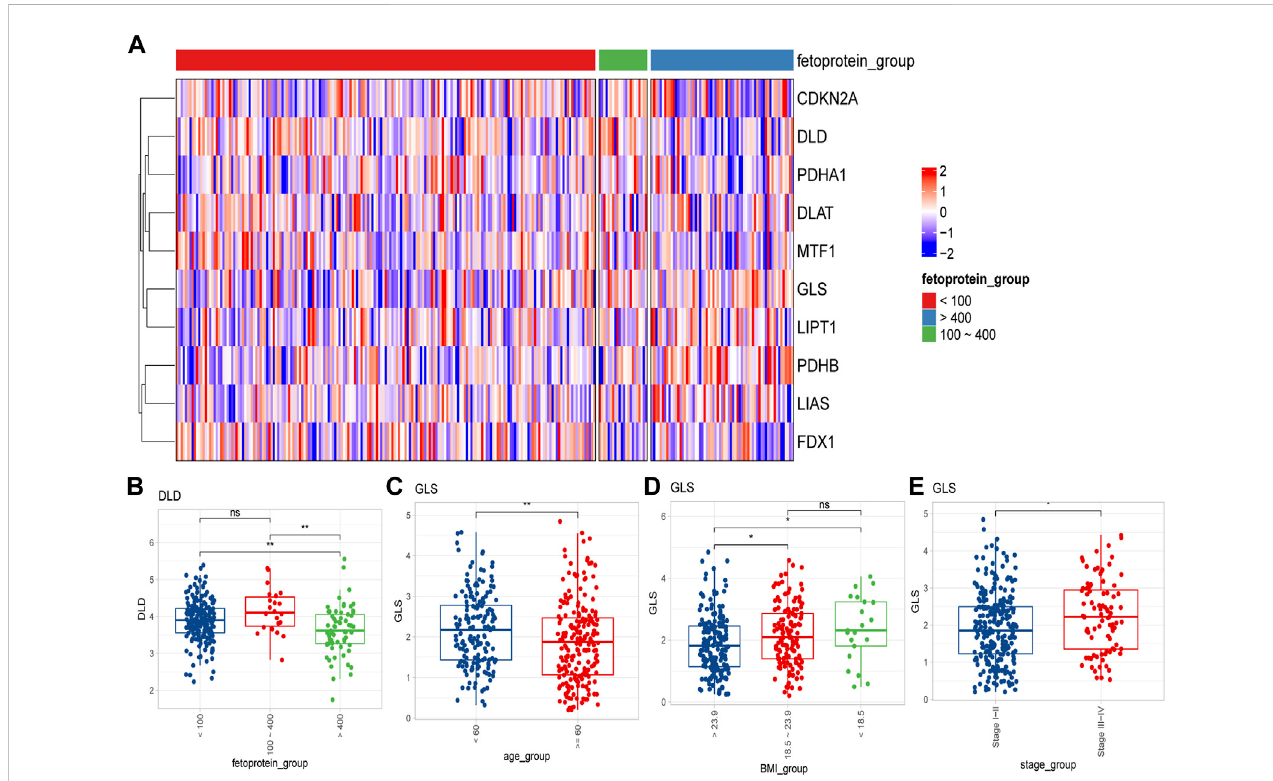
FIGURE 2 Differentialexpressionofcuproptosis-relatedgenesindifferentclinicalfeaturegroups. (A) Expressionof10cuproptosis-relatedgenesindifferentalpha- fetoprotein groups ( < 100 mg/dL, 100 – 400 mg/dL, > 400 mg/dL); (B) DLD expression differences in different alpha-fetoprotein groups; (C – E) The difference of GLS expression in different age, BMI and different tumor stage groups (ns: p > 0.05; *: p < 0.05; **: p < 0.01; ***: p <